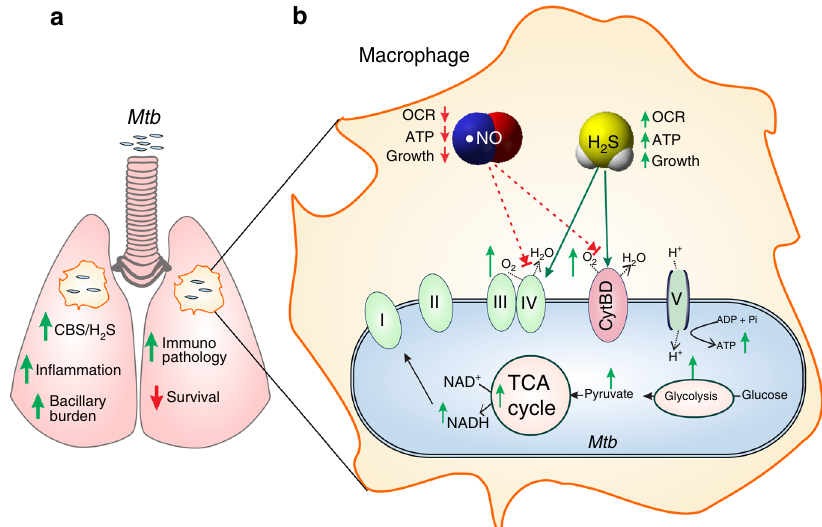
Fig. 7 Proposed mechanism for H 2 S-induced disease exacerbation. a As a response to Mtb infection, the host increases CBS and H 2 S production in the lungs and macrophages leading to increased bacillary burden, increased in fl ammation, and reduced survival. b Host-generated H 2 S is sensed by Mtb to stimulate respiration and energy metabolism, thereby increasing bacterial growth and accelerating disease. During infection, increased H 2 S suppresses iNOS levels